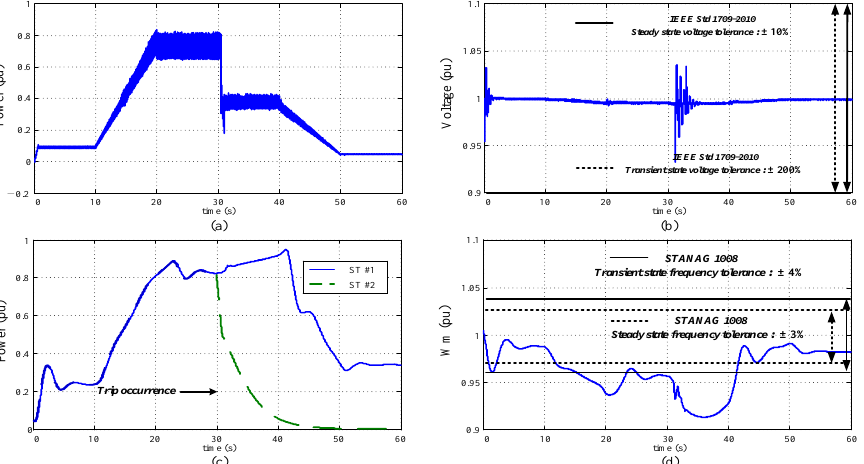
Figure 9. Simulation results of the loss of prime mover trip (without the energy storage system): ( a ) Output power of the propulsion motor; ( b ) Main DC bus voltage; ( c ) Output power of the steam turbine; ( d ) Frequency of the generator.